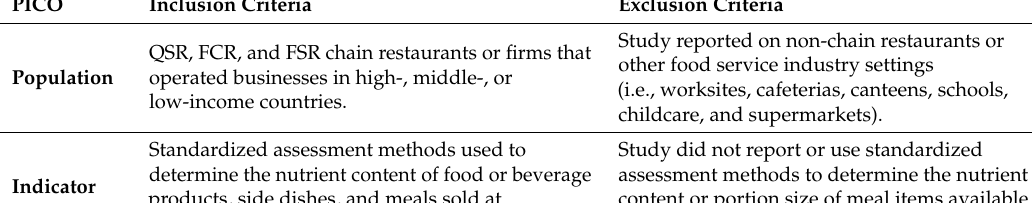
Table 2. Inclusion and exclusion criteria for the study selection for the systematic review. FCR—fast-casual restaurant; FSR—full-service restaurant; TFA—trans fatty acids. PICO Inclusion Criteria Exclusion Criteria QSR, FCR, and FSR chain restaurants or firms that Population operated businesses in high-, middle-, or low-income countries.